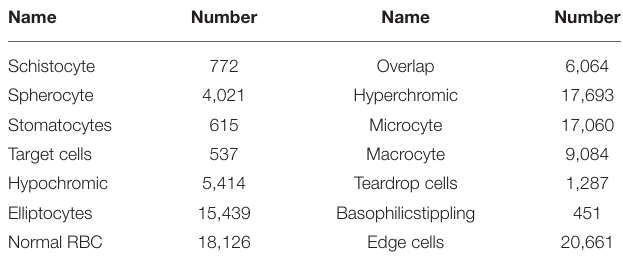
TABLE 1 | Various types of RBCs. TABLE 2 | Allocation of training set and test set (number of cells and number of